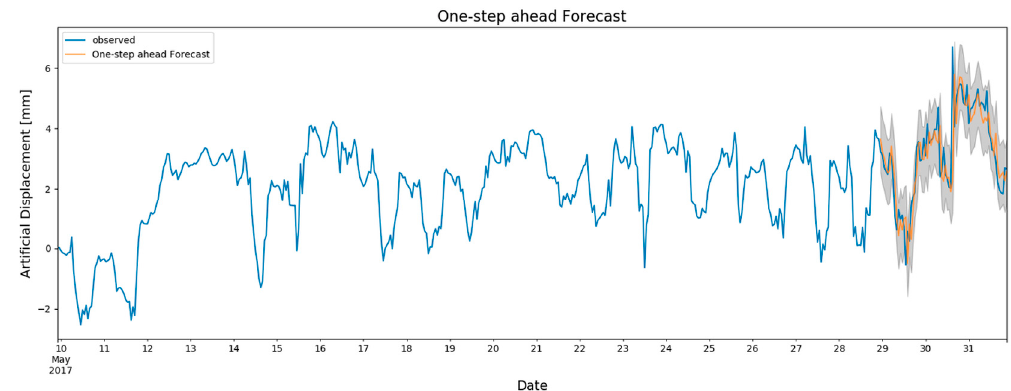
Figure 20. Training data and forecasted results for the apparent displacement time series obtained during the IBIS measurements for the SARIMAX (1, 0, 1) × (0, 1, 1) 24 model.